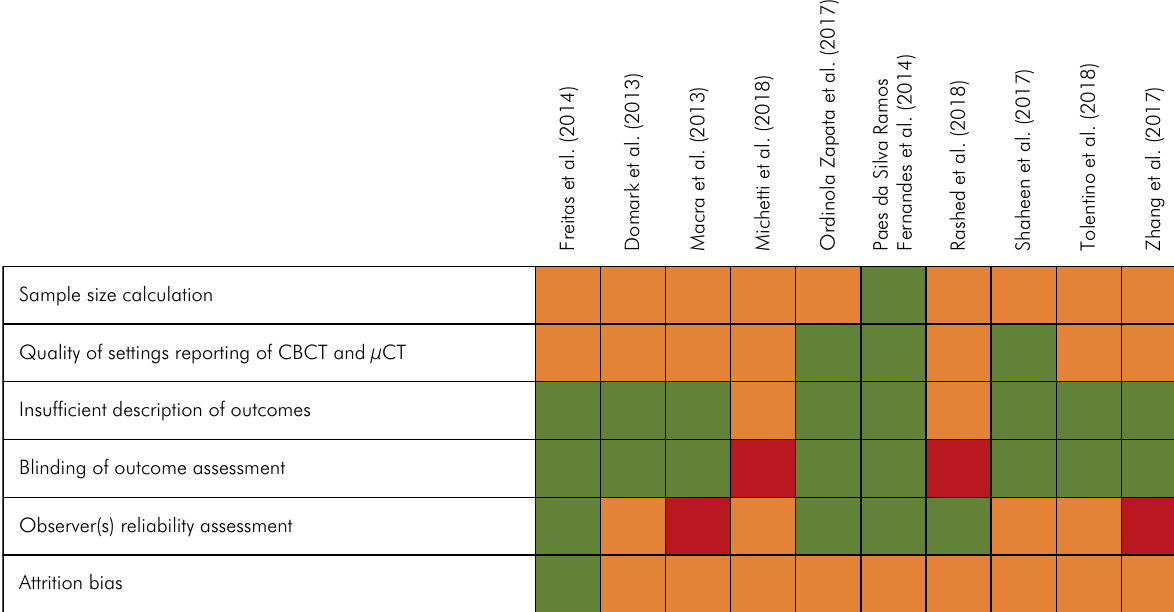
Sample size calculation Quality of settings reporting of CBCT and µCT Insufficient description of